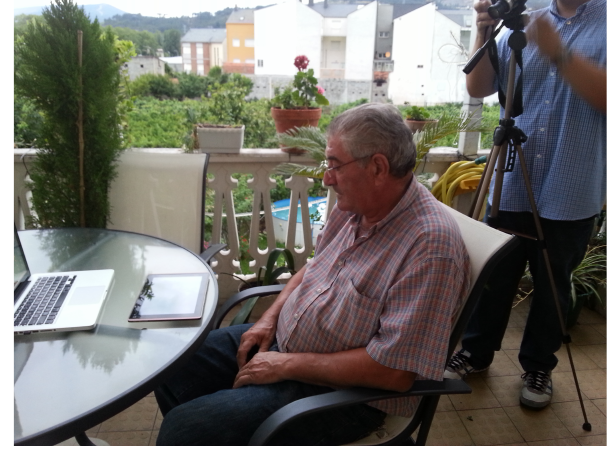
We photographed and recorded video to capture the interaction with the tablet and to register facial features during the tasks, in addition to the application of questionnaires before and after the tests. The initial inquiry aimed to identify the profile of the users in this pilot test through the application of a questionnaire with 12